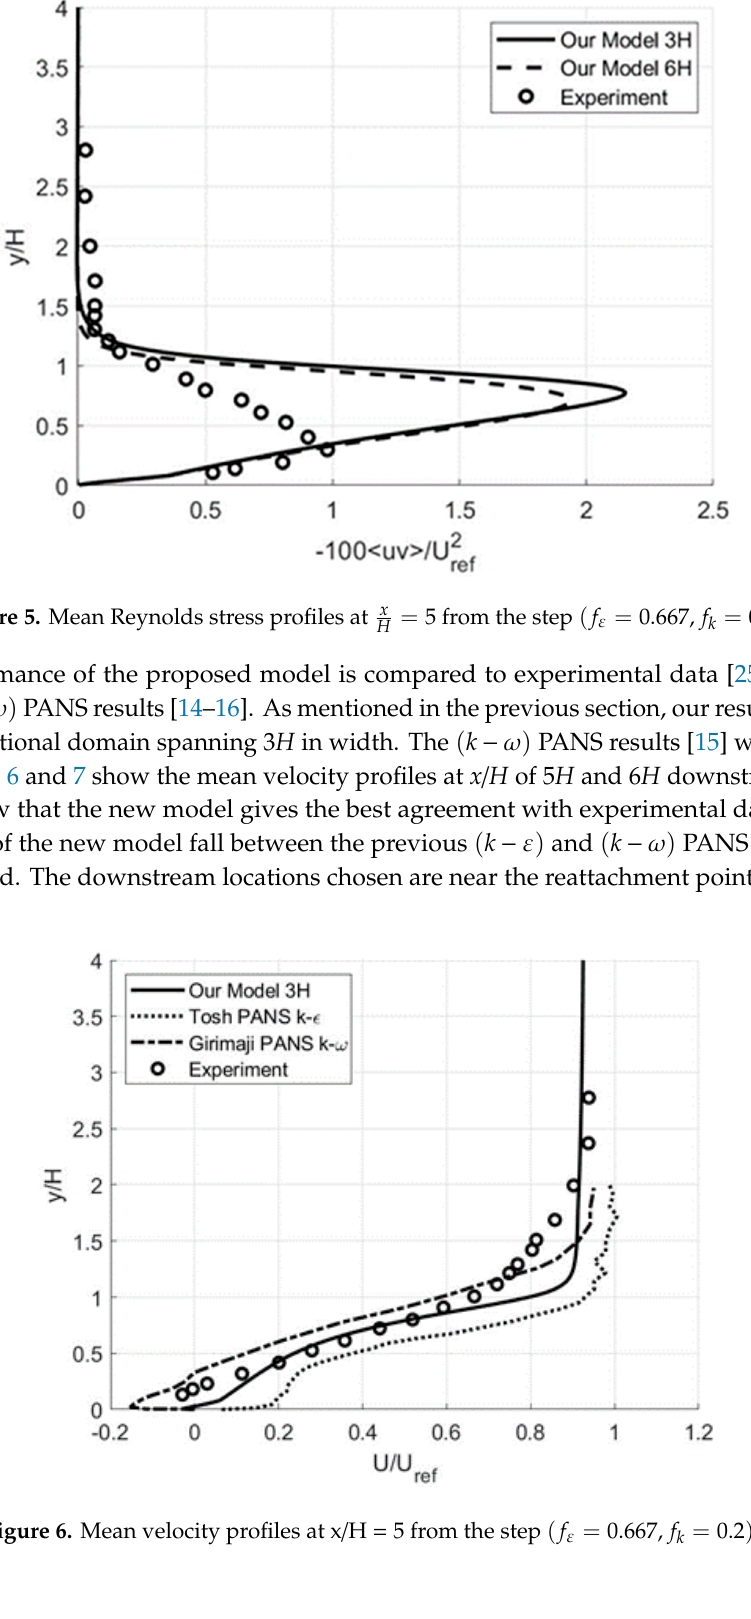
Figure 6. Mean velocity profiles at x / H = 5 from the step ( f ε = 0.667, f k = 0.2 ) .